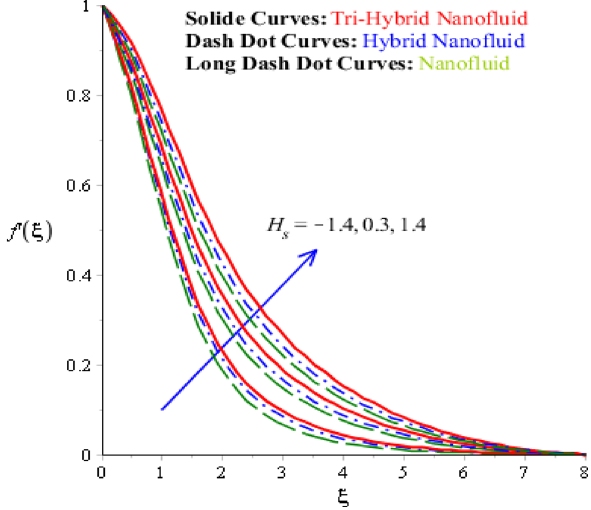
Figure 8. Comparative variation of velocity curves among nanoparticles versus H s .